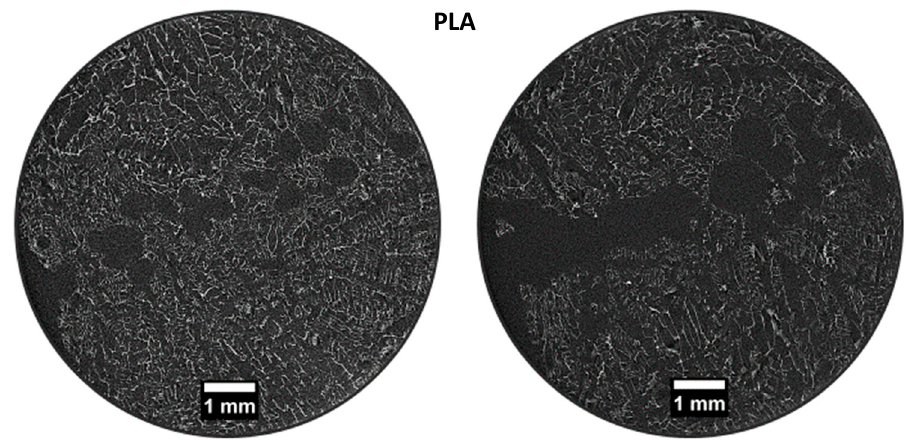
Figure 2. Micro-CT scan of 2 random slices of PLA scaffold, revealing a heterogeneous highly porous structure with a central empty area, attributable to sample brittleness.